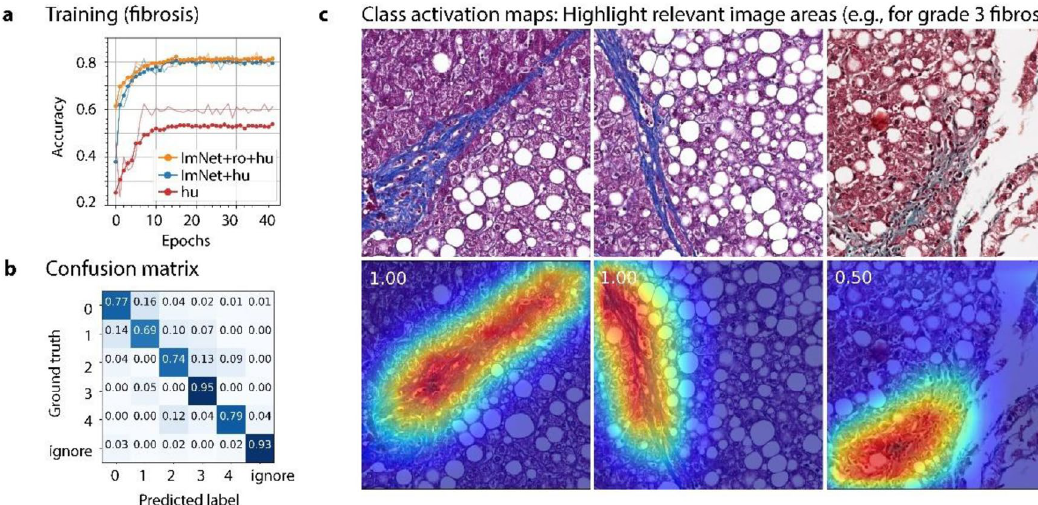
Figure 3. Training, quantitative evaluation, and qualitative visualization of CNN’s decisions in example of the fibrosis model. ( a ) Learning curves of the fibrosis CNN trained under three different pre-training conditions. All learning curves show an increase of accuracy with the training iterations (epochs) followed by a plateau where the final accuracy is reached. Using no pretraining and only the annotated human fibrosis tiles (‘hu’) resulted in relatively poor final accuracy of 61.0%. Prior pre-training with ImageNet (‘ImNet + hu’) resulted in a final accuracy of 79.4%. Additional pretraining with available domain-related data from rodent liver fibrosis (‘ImNet + ro + hu’) resulted in slightly faster learning and marginally better final model performance. Bold lines are performances on the validation set, thin lines on the training set. ( b ) A confusion matrix compares the CNN classifications on unseen validation tiles with the ground truth from the pathologist. ( c ) Class activation maps (CAM) allow showing relevant regions for the decision of a CNN for a certain class. Here, the activations for the fibrosis model and grade 3 fibrosis (bridging fibrosis) are shown. The number at the top left of the CAM indicates the CNNs confidence for grade 3 fibrosis. The right column shows a case with more ambiguity.